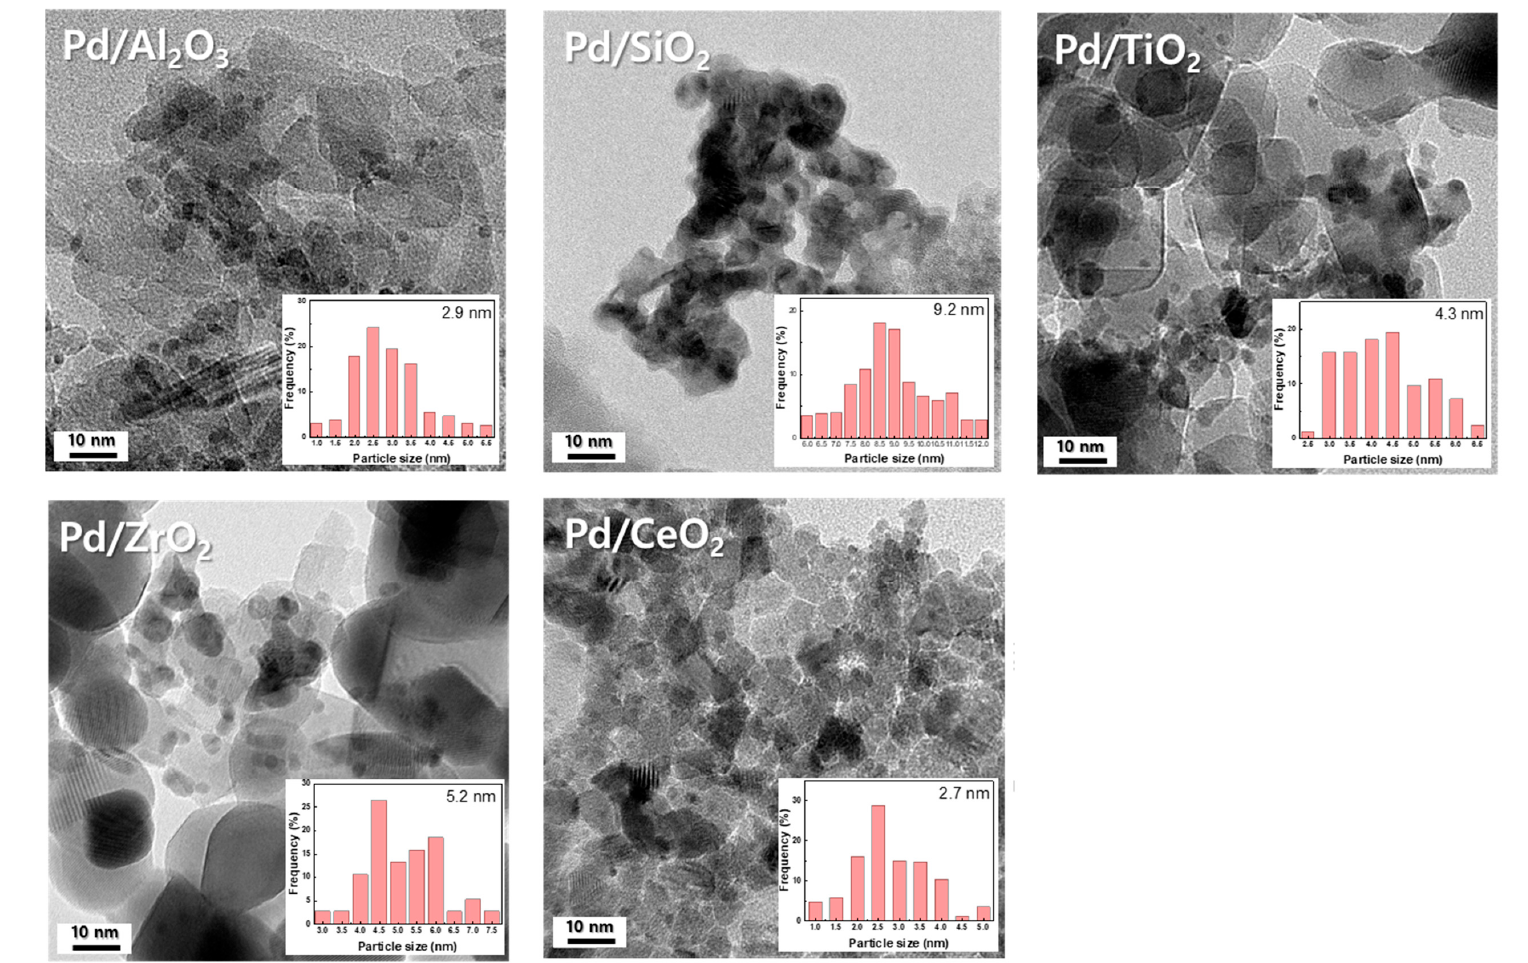
Figure 8. FE-TEM images and particle size distributions of Pd catalysts.